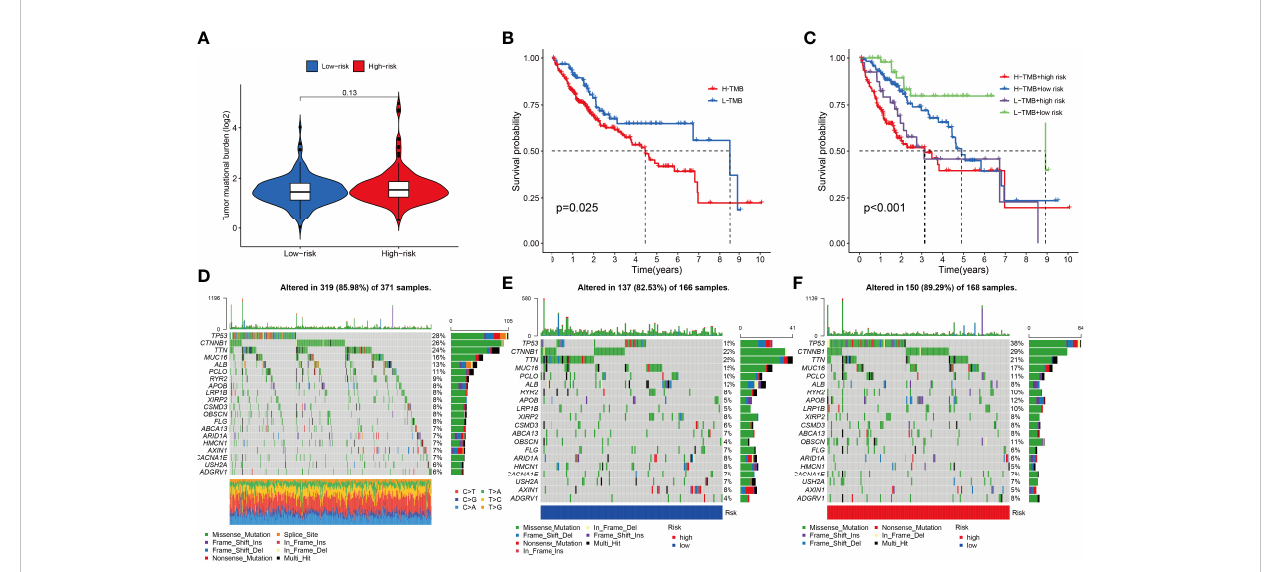
FIGURE 9 (A) Combined F-NLR signature model to assess the expression of tumor mutational burden (TMB) in high- and low-risk groups. (B, C) Survival analysis of TMB in the TCGA-LIHC cohort. (C) Survival analysis of TMB with risk group in the TCGA-LIHC cohort. (D) Gene mutation information of the TCGA-LIHC cohort. (E) Gene mutations information of patients in the low-risk group. (F) Gene mutation information of patients in the high-risk